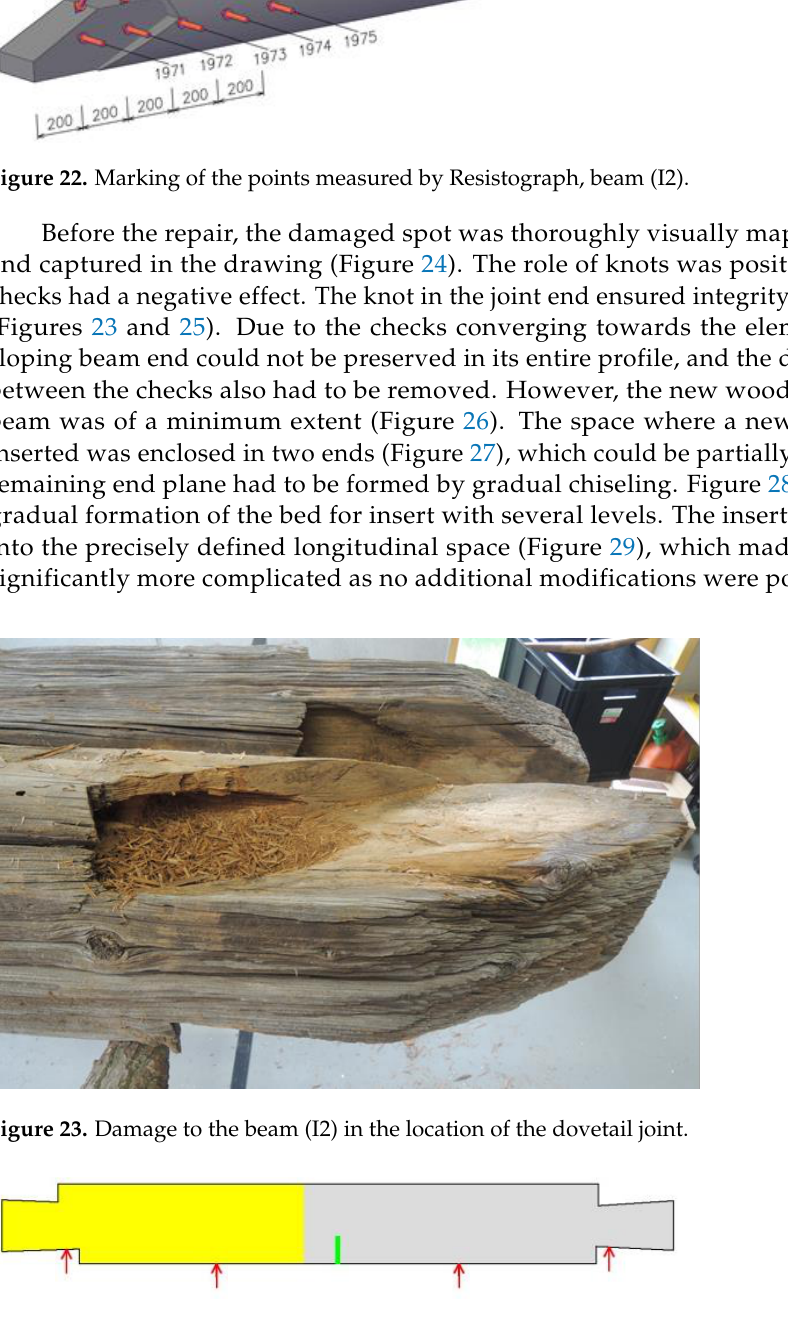
Figure 21. Graphic records from the individual measurement points using the Resistograph drill, beam (I2), measured vertically in the centre of the element.